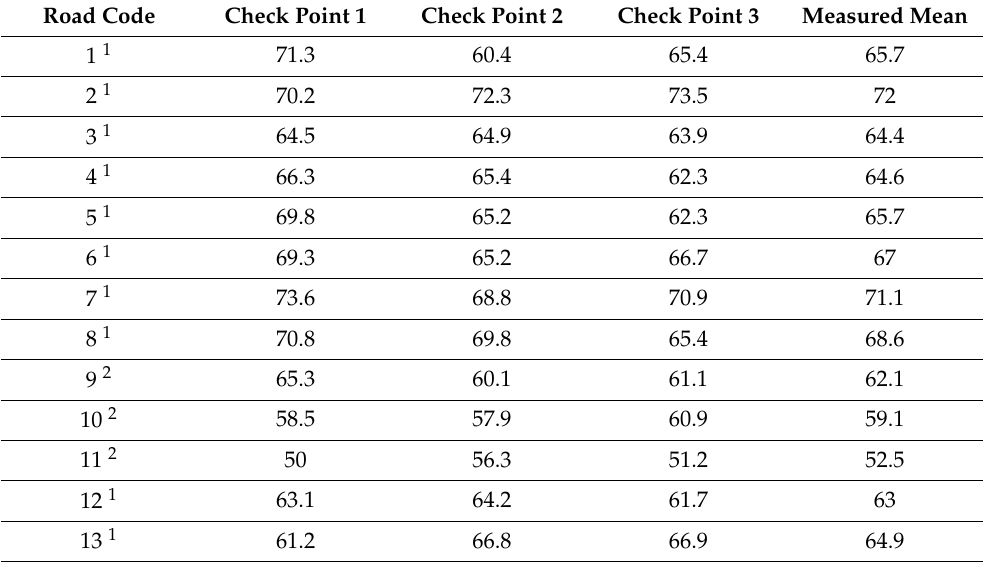
Table 1. Noise level measurement results and descriptive statistics for the 13 roads crossing the potential quiet areas.